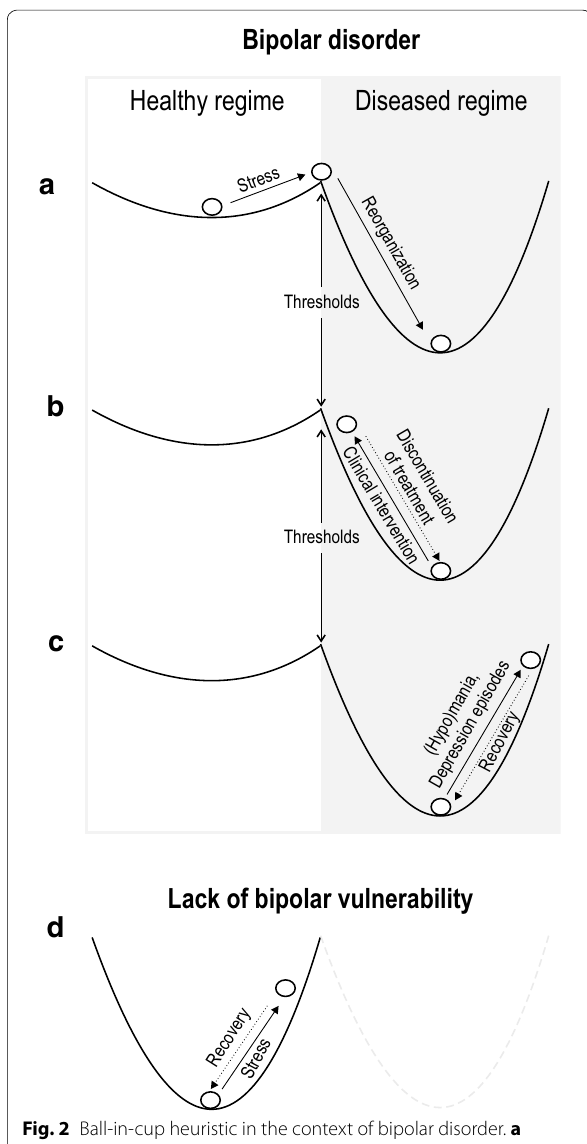
Fig. 2 Ball‑in‑cup heuristic in the context of bipolar disorder. a Individual with bipolar vulnerability (symbolized with the shallow cup). Stressful life events trigger the chronic, incurable disorder (sym‑ bolized with the ball rolling from the healthy into a new (diseased) regime once a stress threshold has been passed). b Bipolar individual receiving healthcare (medication, therapy). Clinical intervention does not restore the regime prior to the outbreak of the disorder (no recovery). Instead, it ameliorates symptoms and increases personal and interpersonal functioning of the patient within the diseased regime (full arrow). Discontinuing clinical treatment (dotted arrow) eventually restores the full symptomatology. c Engineering resilience subsumed within ecological resilience: shown are stress‑recovery patterns related to episodes of (hypo)mania and depression in the diseased regime. d Individual without bipolar vulnerability (i.e., in a healthy regime) recovering from adverse situations (stress). The lack of vulnerability is also symbolized by the absence of a diseased regime (gray dotted cup). Note that similar to persons without disposition to bipolar disorder, stress–response dynamics also occur in the healthy regime of patients with bipolar disorder (not shown in the